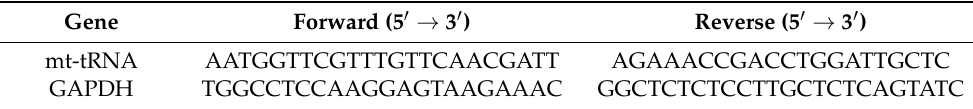
Table 6. List of gene-specific primers for the real-time PCR